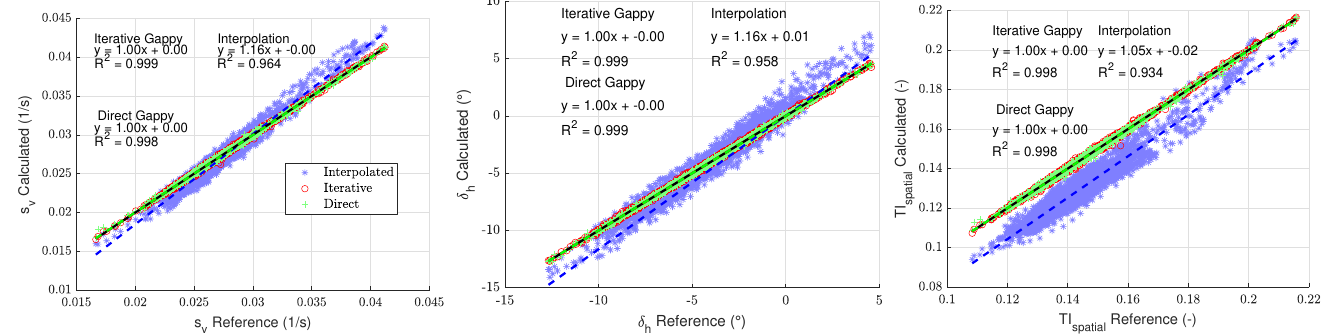
Figure 14. Comparison of s v , δ h and TI Spatial calculated from the reconstructed data for the SBL case with G =